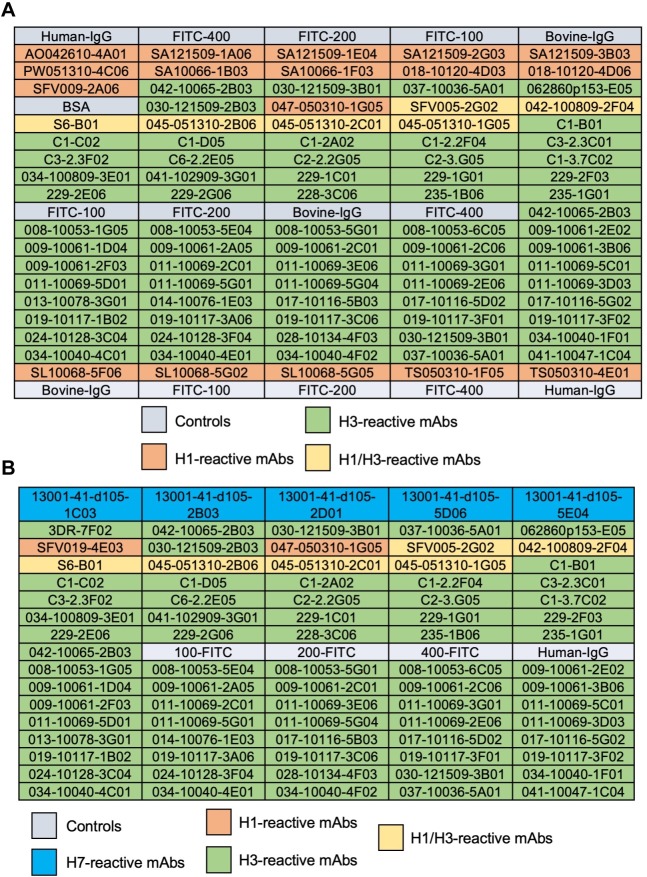
Layout information of the array.(A) Array for rCIV-11613, rCIV-23, and human HK68 or (B) Wis05 H3N2 viruses. Human IgG was used as control for nonspecific IgG binding. Three anti-fluorescein (anti-FITC) solutions were uses as negative control at a concentration of 100 μg/ml (FITC-100), 200μg/ml (FITC-200) and 400μg/ml (FITC-400). Bovine IgG secondary antibodies reactive to the bovine sera used for blocking were used as positive control.